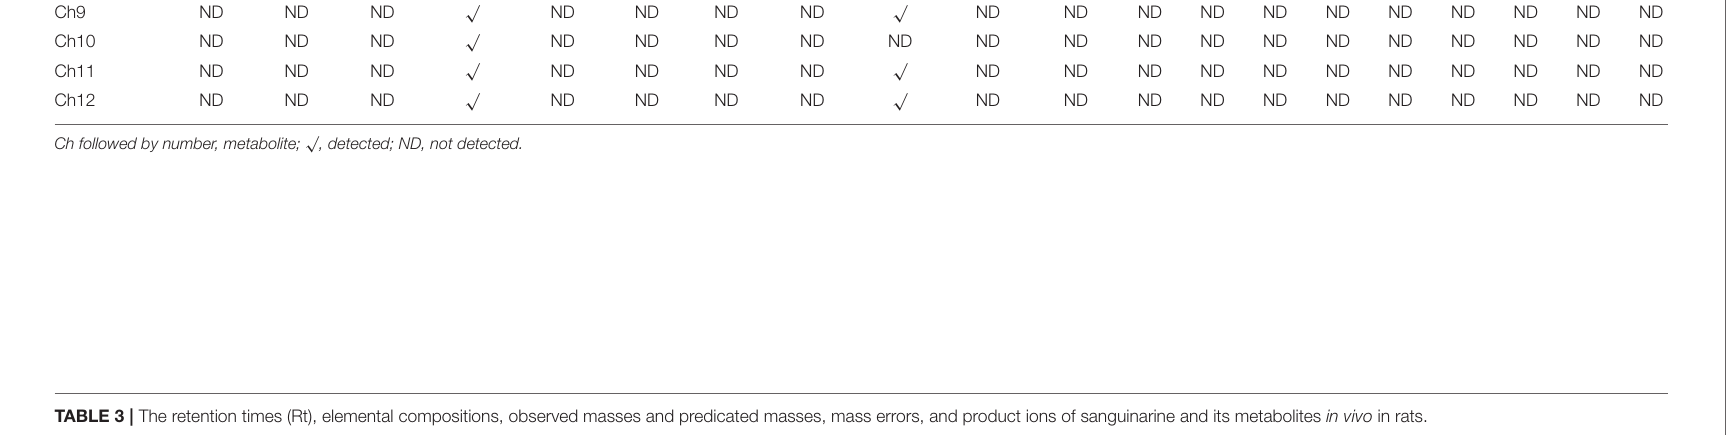
TABLE 3 | The retention times (Rt), elemental compositions, observed masses and predicated masses, mass errors, and product ions of sanguinarine and its metabolites in vivo in rats. Compound Rt (min) Elemental composition Observed